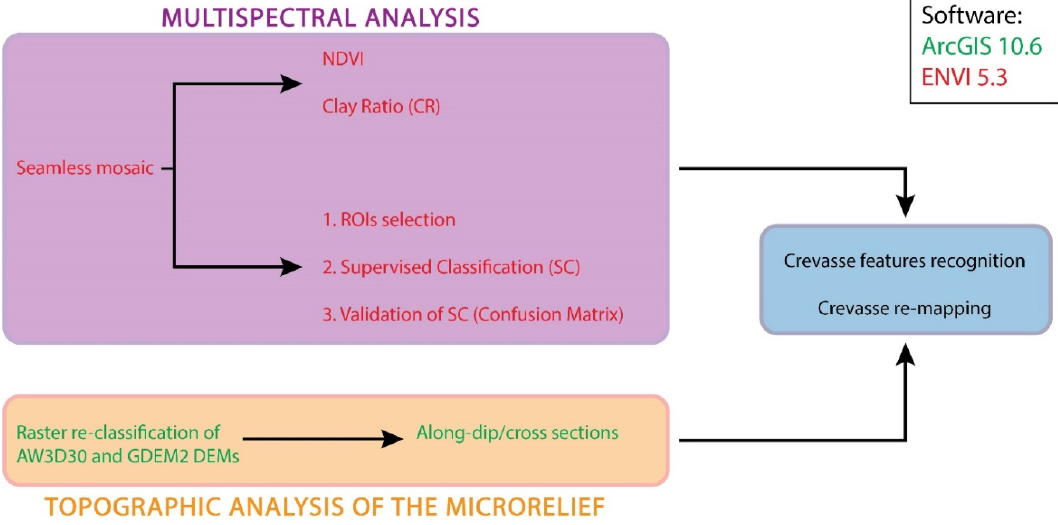
Figure 5. The adopted methodological scheme (workflow and software) for the analyses conducted in this research.